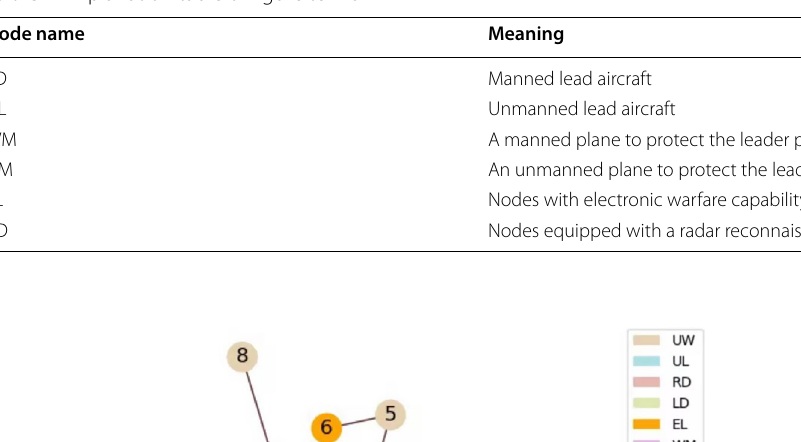
Table 2 Explanation table of figure terms